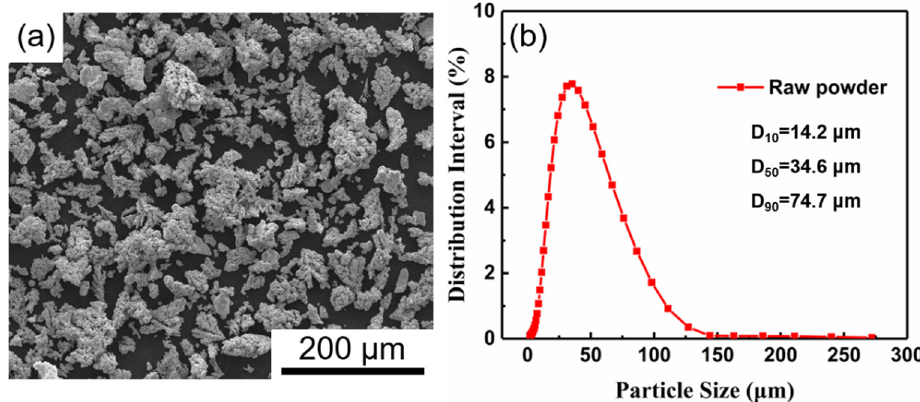
Figure 1. Raw copper powder: ( a ) morphology, ( b ) particle size distribution.